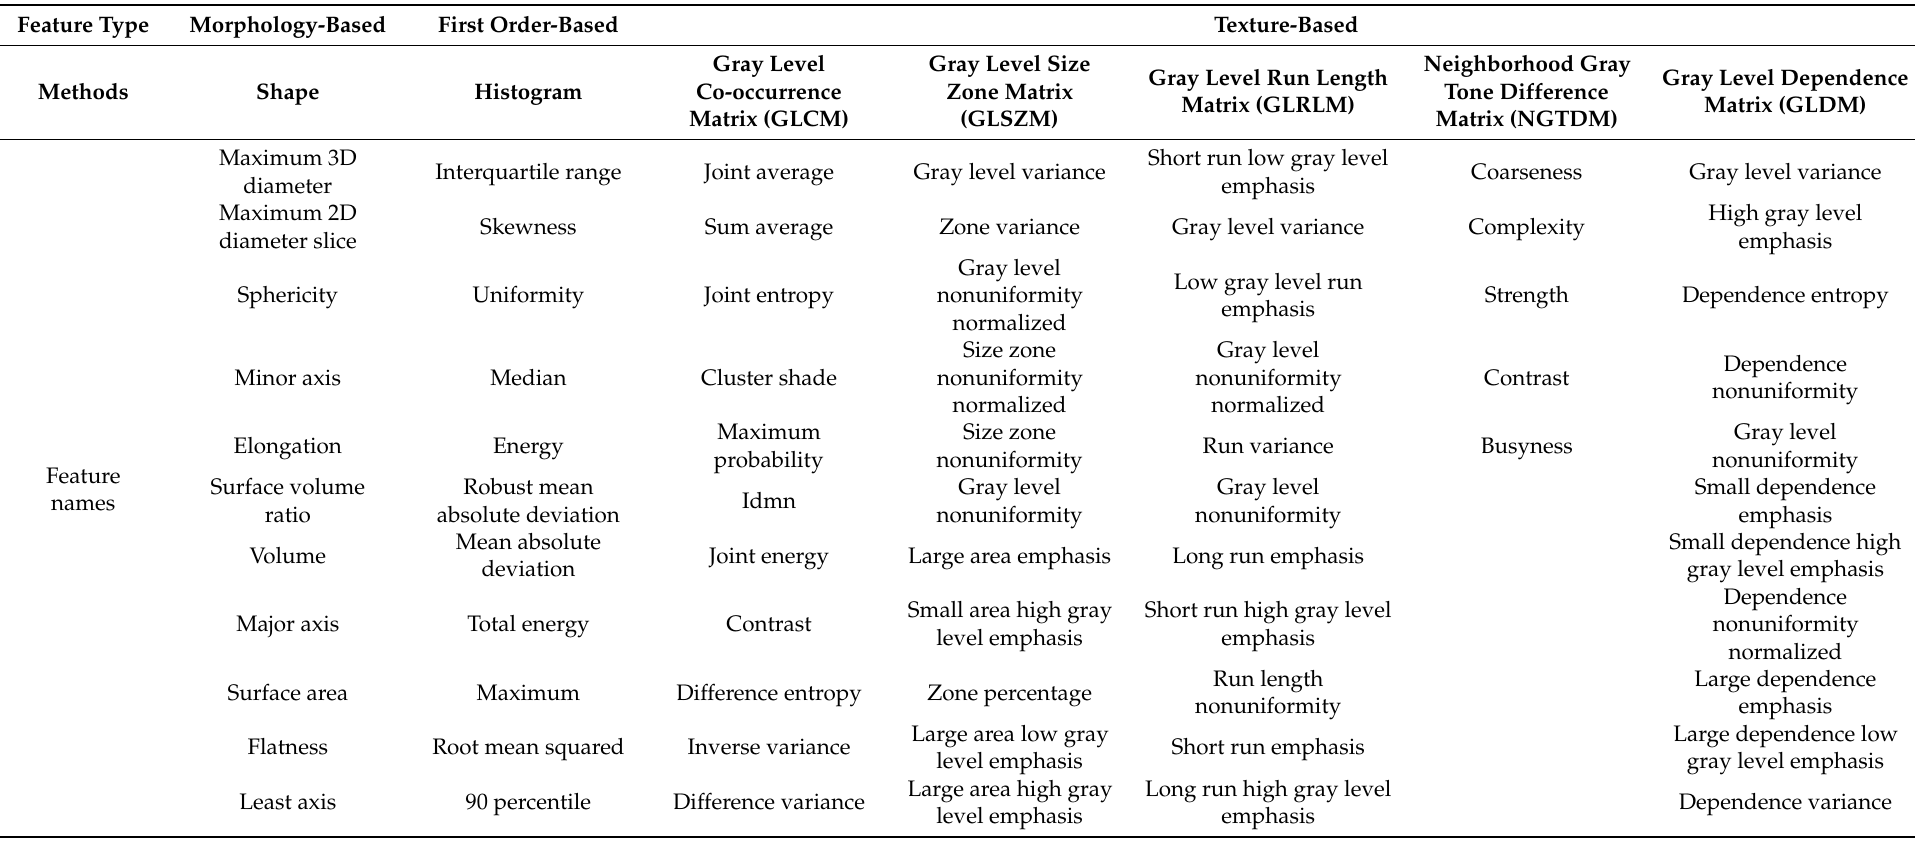
Table 2. Feature type and associated